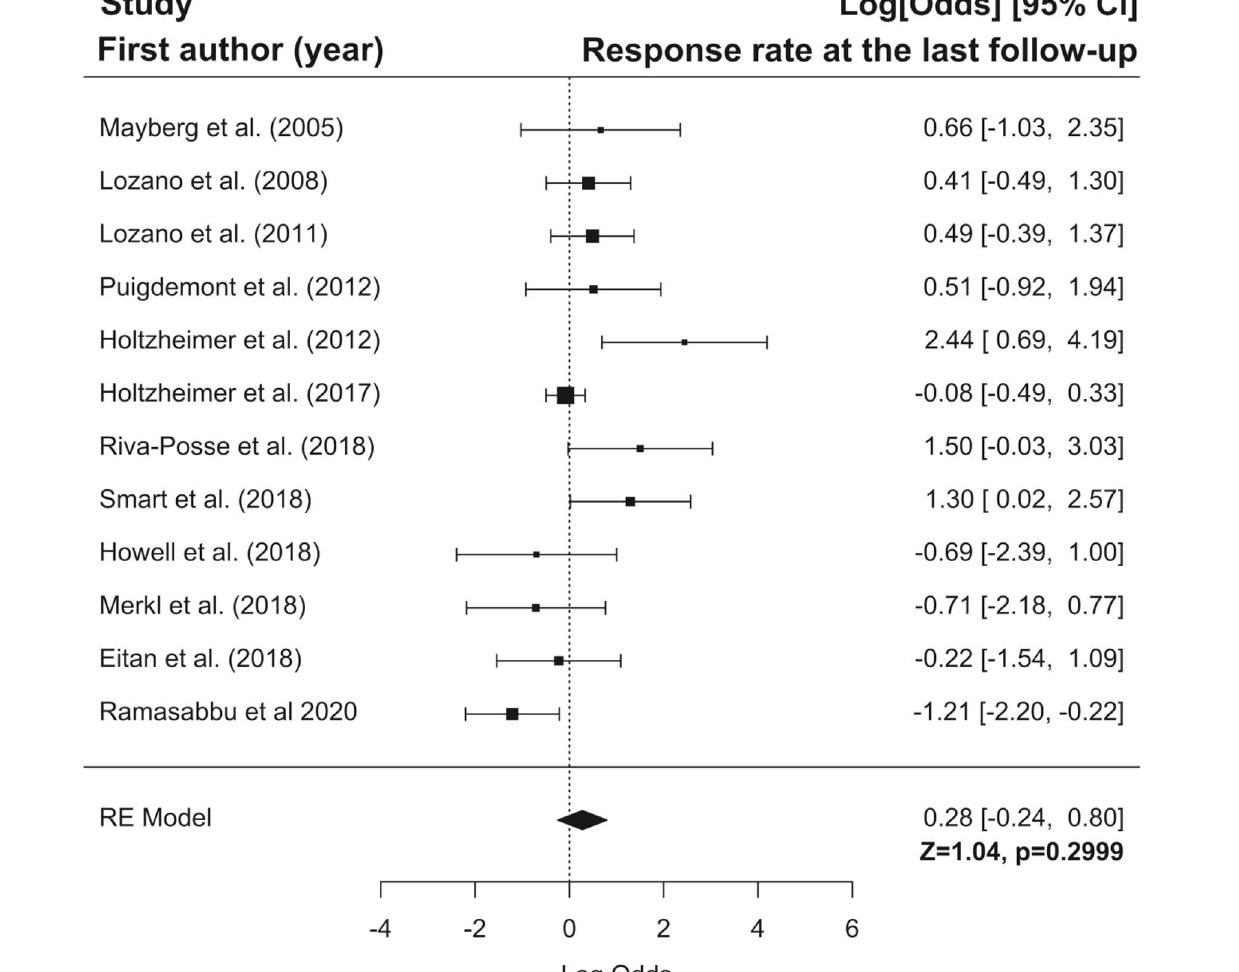
scores, proportion for remissions was equal to 0.399 (with 95% CI: 0.2923 to 0.5158), Z = − 1.7, p =